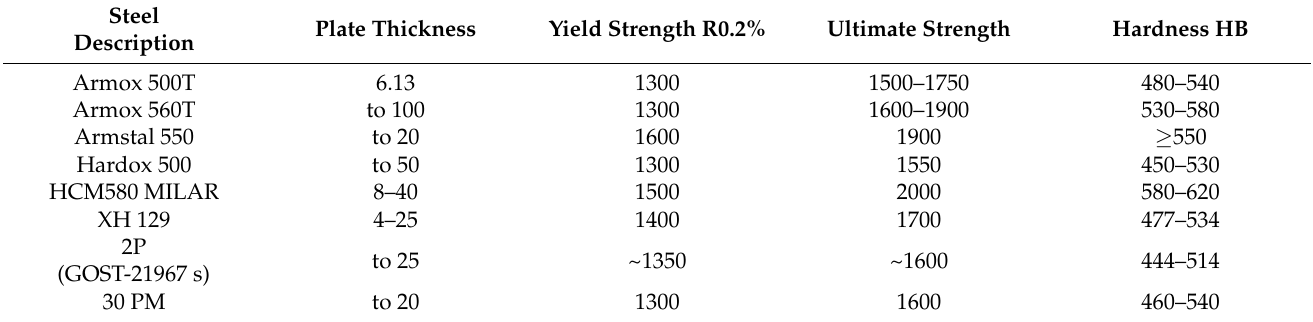
Table 1. Comparison of properties of selected high-performance armour steel alloys based on [1,3].